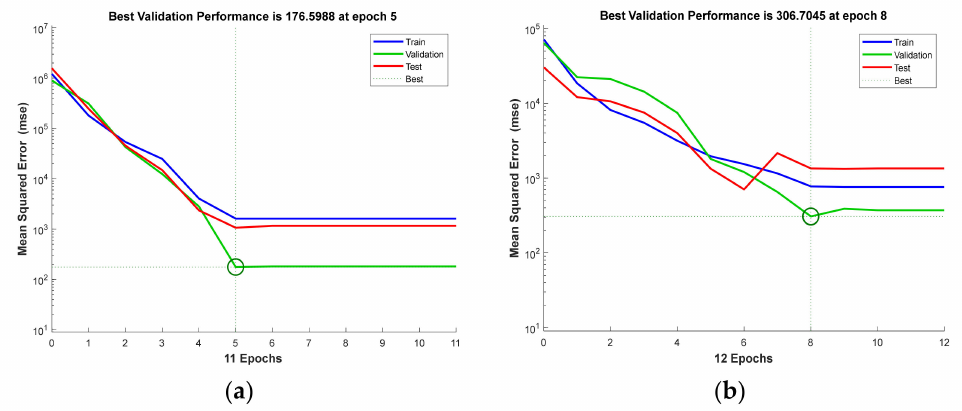
Figure 5. MSE training results of the training, validation, and testing stages for the ( a ) BFRP and ( b ) GFRP predictive